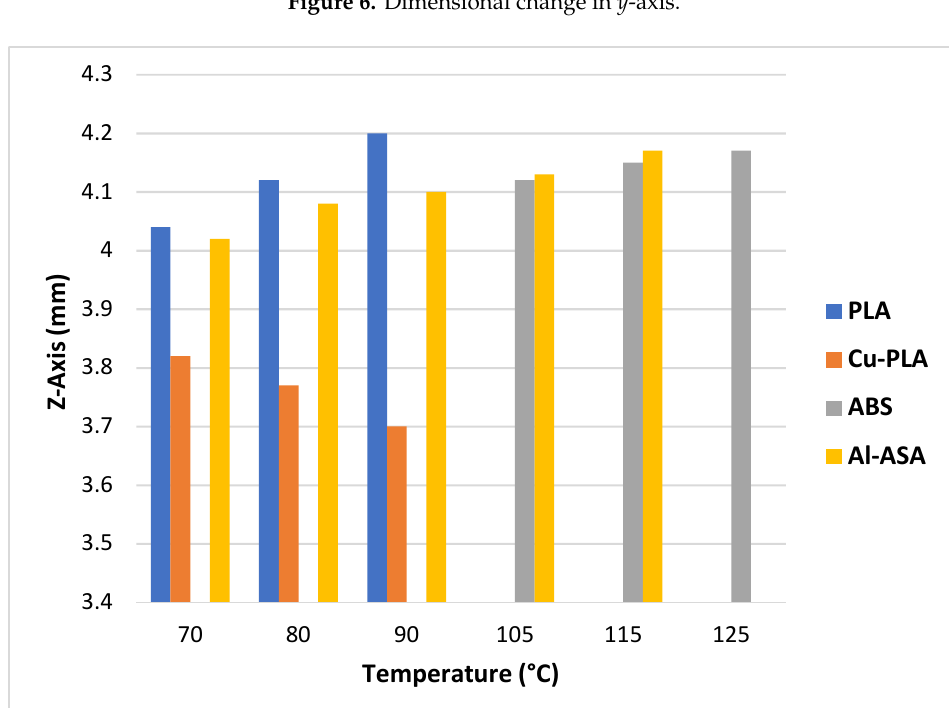
Figure 6. Dimensional change in y -axis.